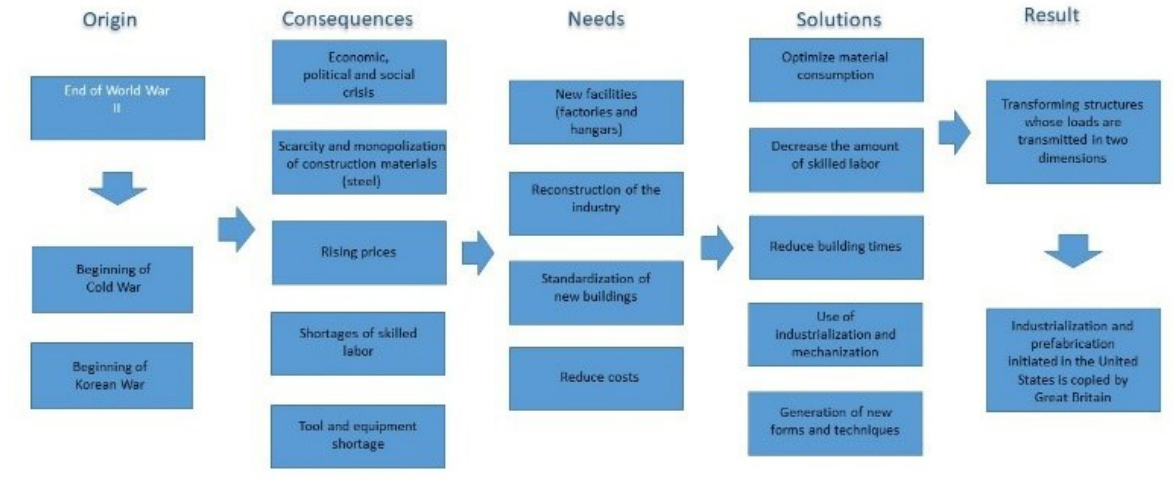
Figure 6: The building industry after Second World